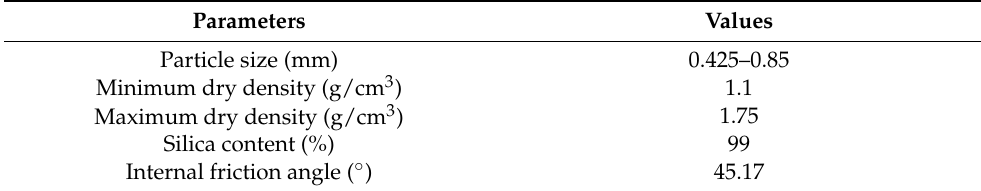
Table 2. Physical properties of white quartz sand.